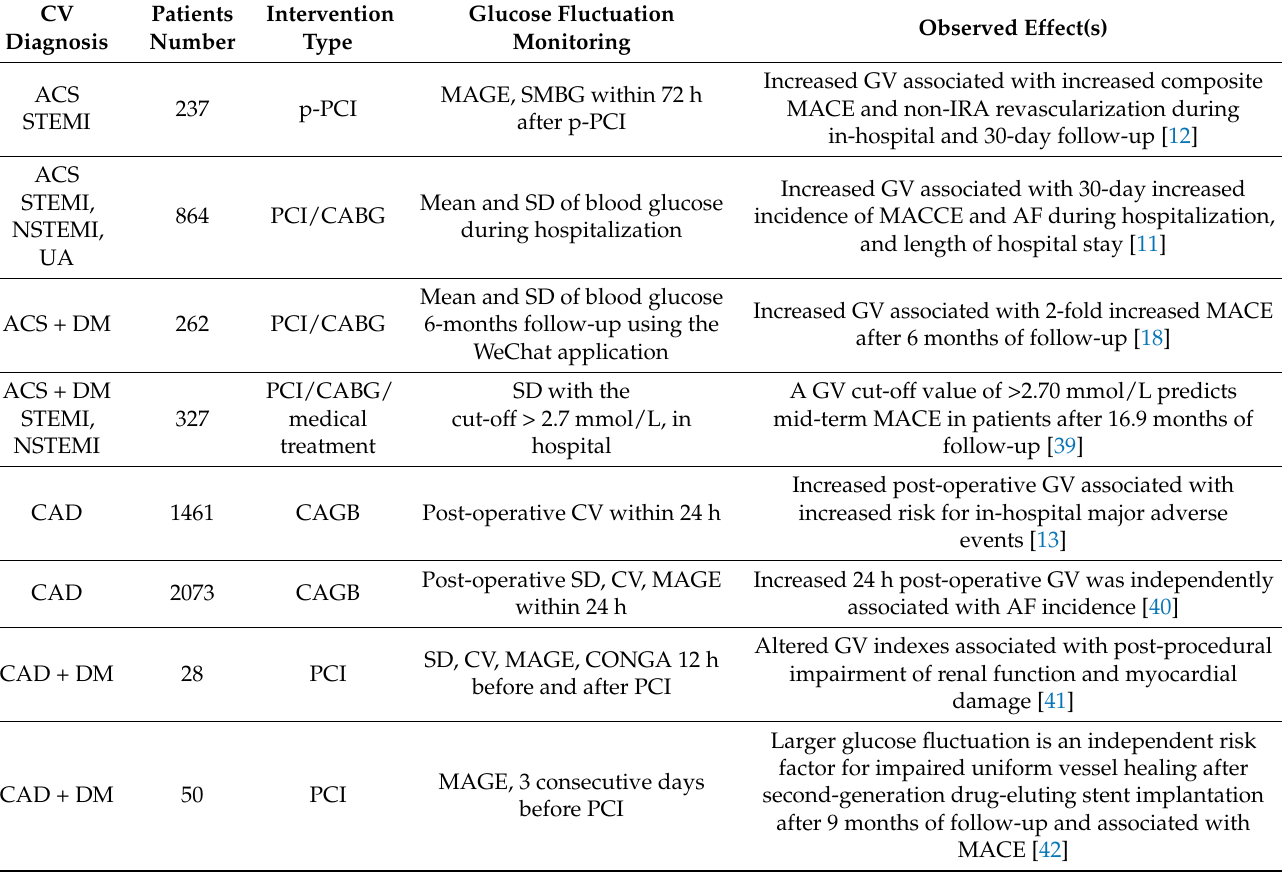
Table 2. Glucose variability and cardiovascular